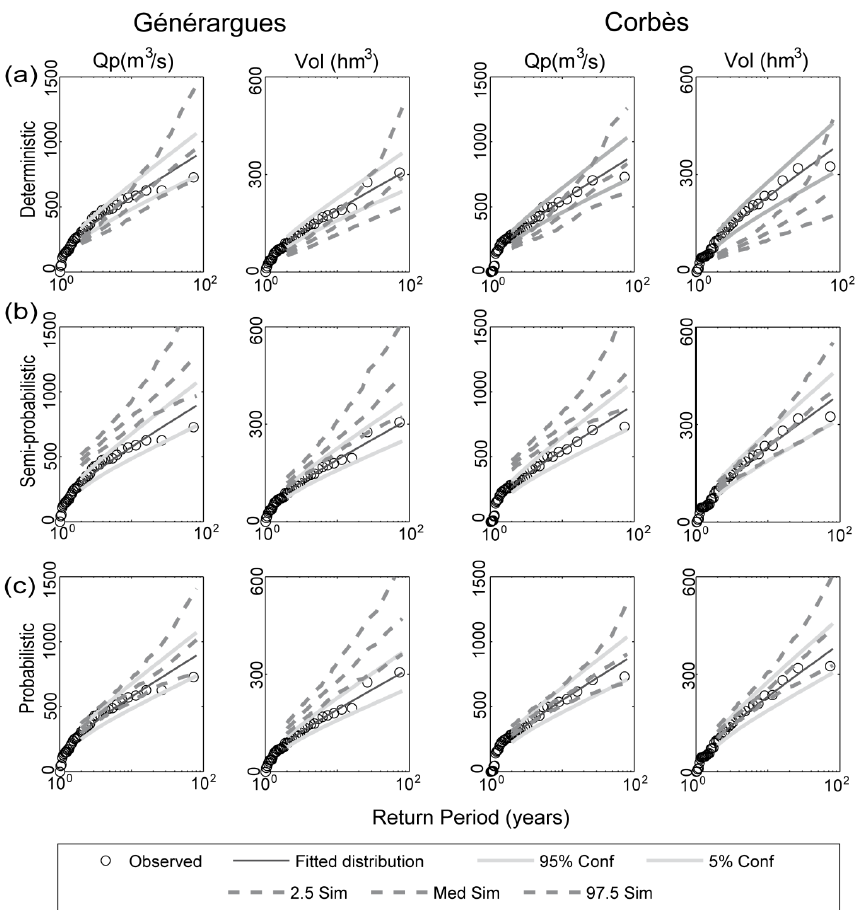
Figure 11. Frequency curves of the peak flow and the associated hydrograph volume for the Générargues and the Corbès basins: ( a ) Deterministic; ( b ) semi-probabilistic; and ( c ) probabilistic. Observed data (circles); Distribution fitted to the observed series (solid line) with its 95% confidence limits (dotted line); median and 2.5% and 97.5% percentiles of model simulations (dashed lines). Table 5. NSE values calculated for the simulated peak flows and hydrograph volumes by the deterministic, semi-probabilistic and probabilistic approaches. The bold text shows the approach that fits best and the italics text shows the worst fit.